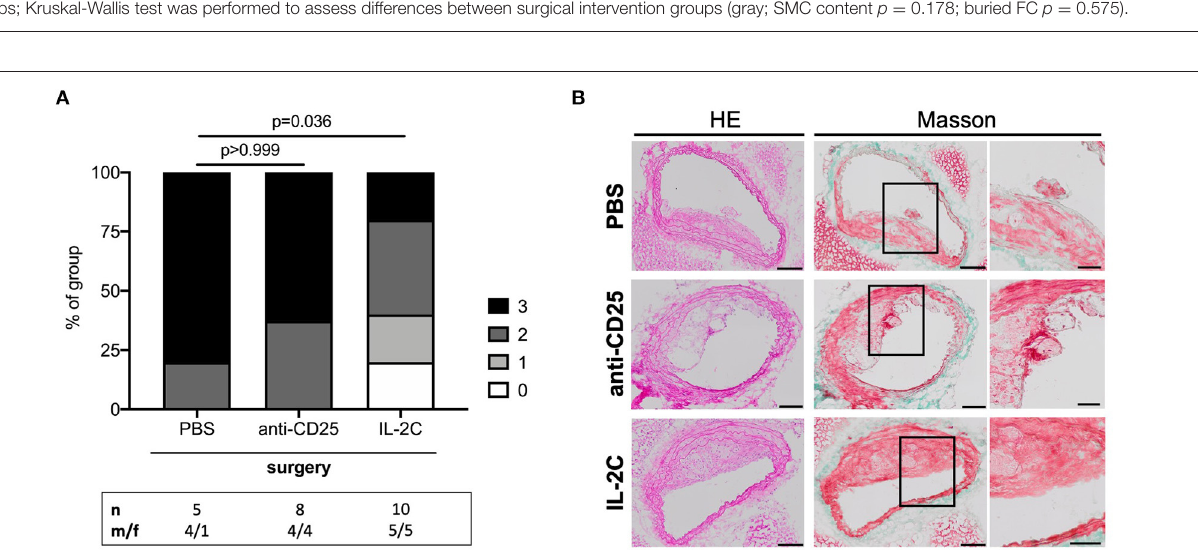
FIGURE 7 | Post-surgical atherosclerotic plaque complexity stratified by preoperative Treg level. (A) Atherosclerotic plaques were scored and classified by complexity based on the presence of necrosis, buried fibrous caps and intraplaque hemorrhage at the site of maximum stenosis. If all criteria were met, plaques were assigned three points denoting the maximum complex lesion phenotype. The total number of mice under study as well as the ratio of male to female mice is indicated per group. Plaques with a maximum stenosis < 10% were excluded from the analysis resulting in n = 5–10 mice per group. Kruskal-Wallis test ( p = 0.024) followed by Dunn’s post-hoc test were used to evaluate differences between PBS- and anti-CD25 mAb- or IL-2C-treated animals, respectively. (B) Representative micrographs of hematoxylin/eosin- and Masson trichrome-stained cross-sections derived from surgical intervention groups showing ruptured atherosclerotic plaques in mice treated with PBS and anti-CD25 mAb (scale bar 100 µ m). High-magnification images are shown for box-indicated regions (scale bar 50 µ